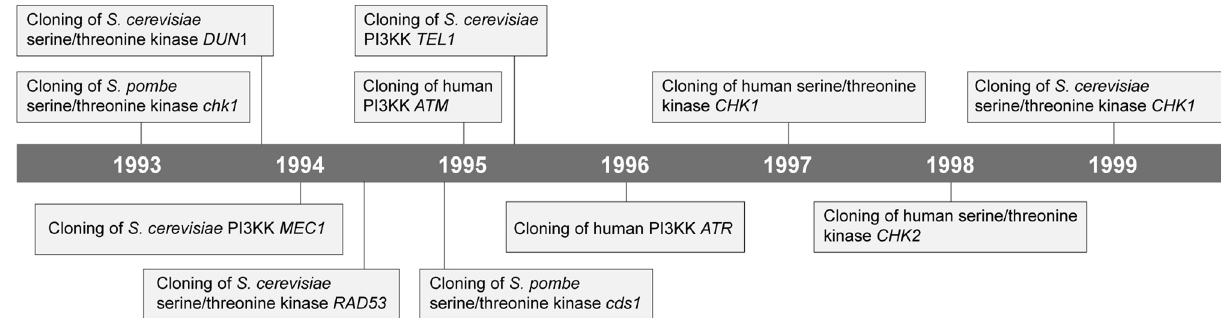
Figure 1 - Timeline for the discovery of DDR kinases in yeast and human. Although the gene encoding S. pombe Chk1 was identified before Dun1, its kinase activity was associated with DDR only in 1996 (Walworth and Bernards,